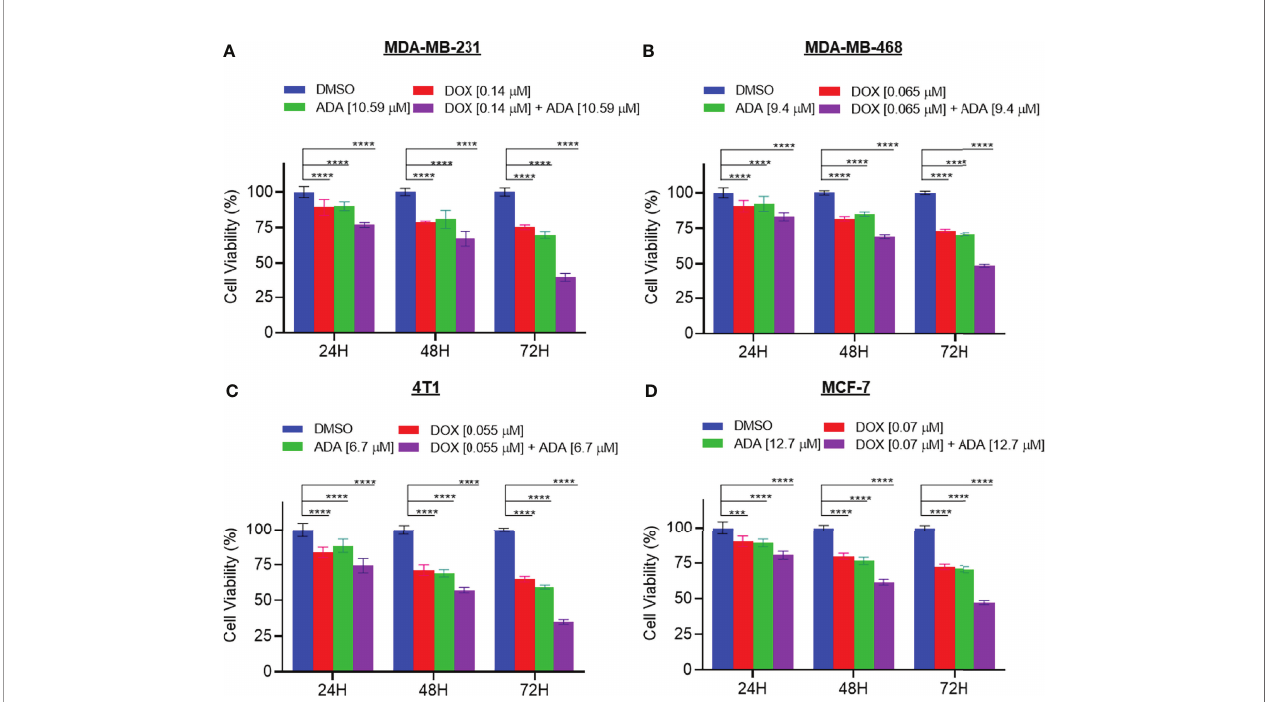
FIGURE 3 | The combination of doxorubicin and adapalene synergistically reduces tumor cell proliferation. The combination of DOX and ADA inhibited proliferation of (A) MDA-MB-231, (B) MDA-MB-468, (C) 4T1 and, (D) MCF-7 in a synergistic manner. Data are mean ± SD. p-values were determined by two-way ANOVA followed by Tukey ’ s multiple comparisons test (***p < 0.001; ****p < 0.0001). Signi fi cant reduction in cell viability was observed when treated in a time-dependent manner with combined treatment of DOX and ADA showing maximal effect. Data are representative of at least three independent